Question: Looking at the figure, what chart type is it?
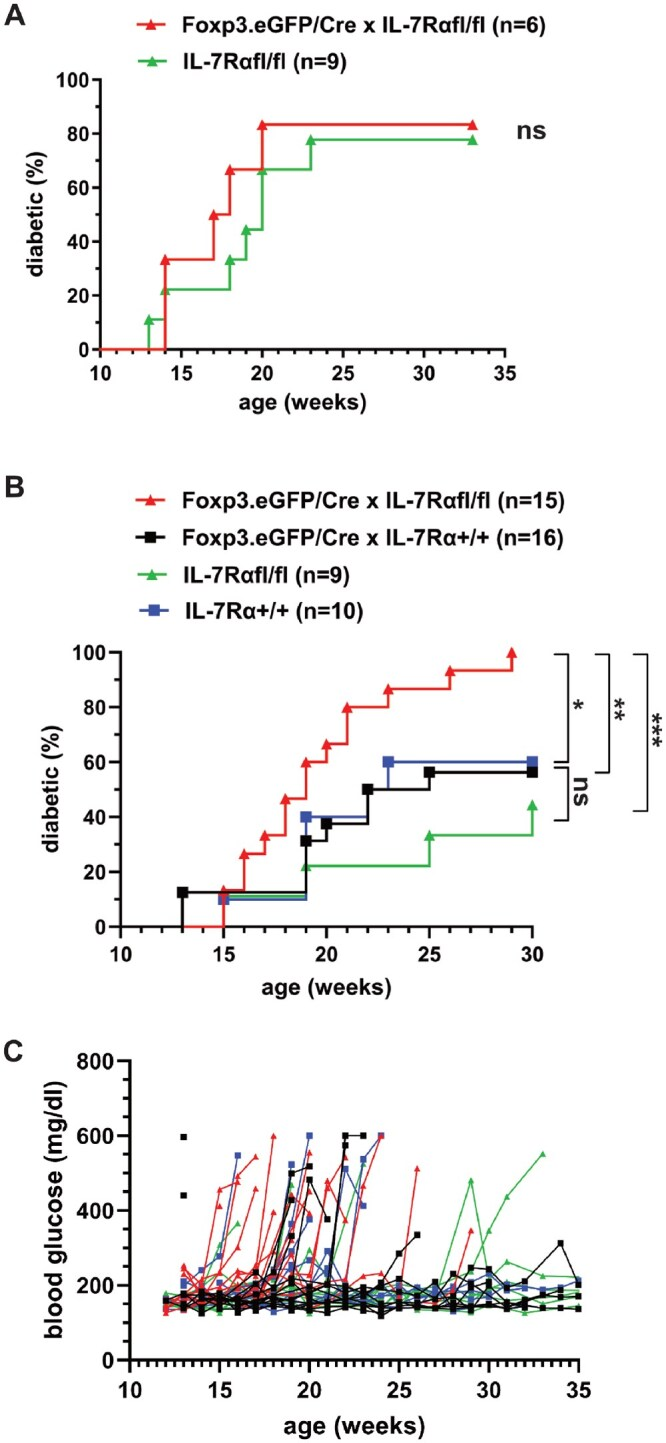
Answer: survival